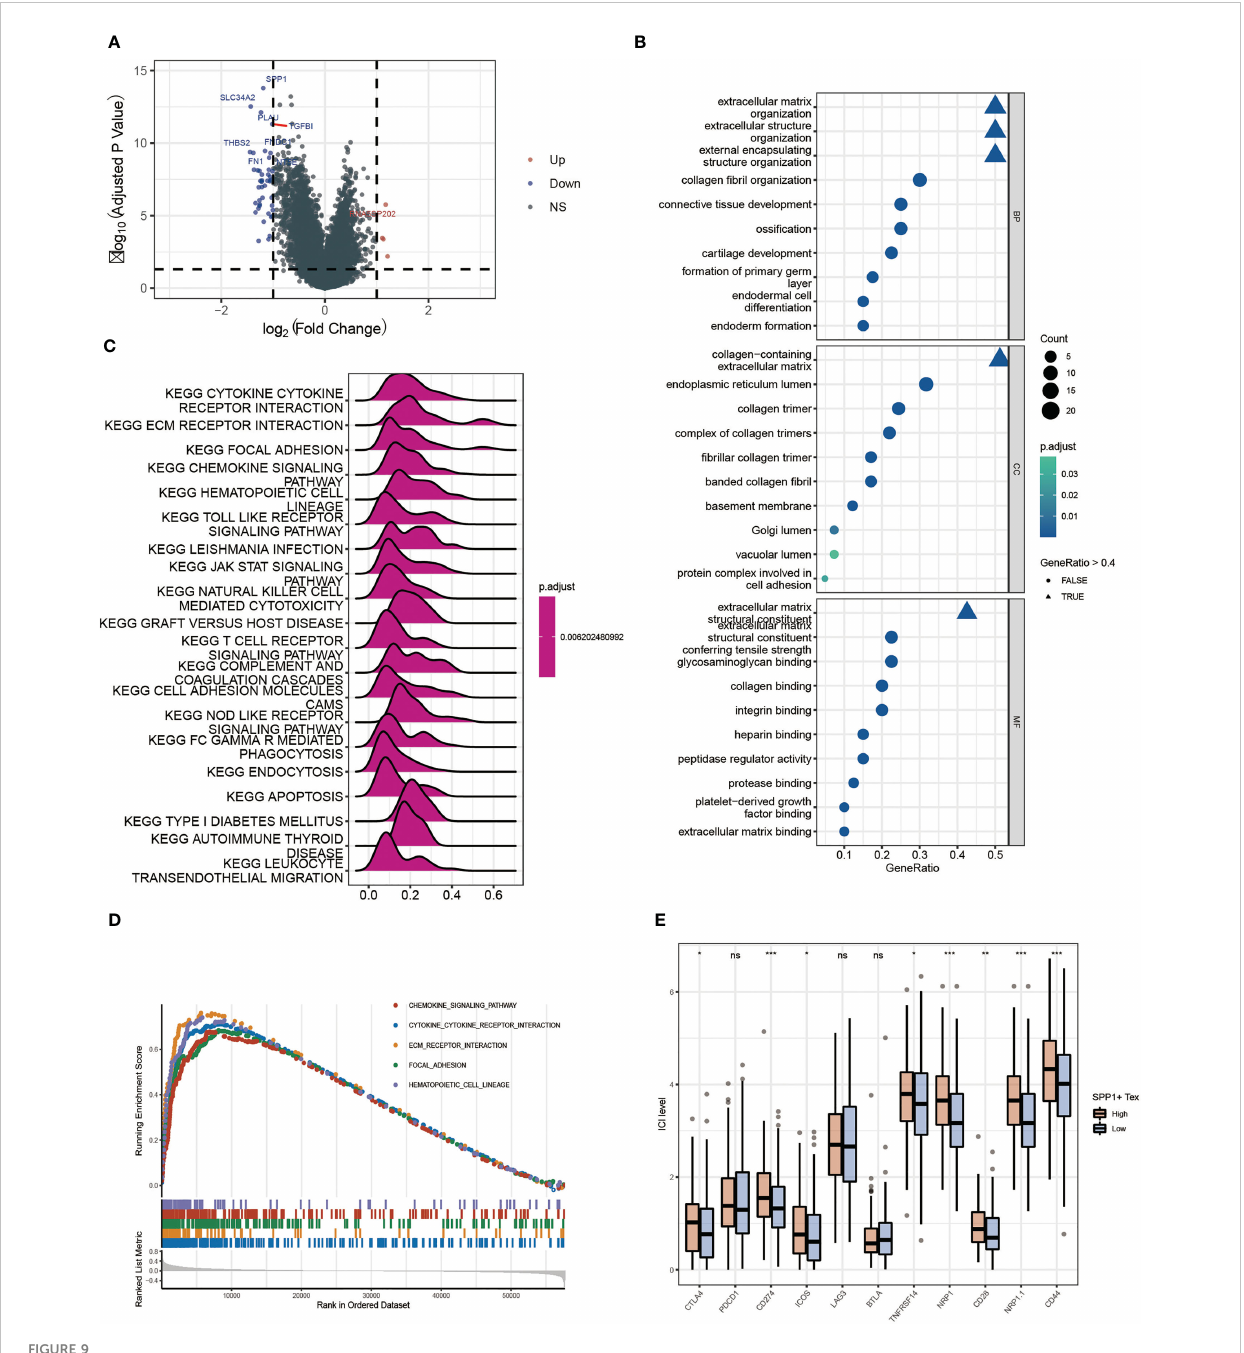
FIGURE 9 Differential enrichment analysis between high and low SPP1 + Tex groups. (A) Volcano plot of differentially expressed genes analysis between high and low groups. (B) GO enrichment analysis bubble plot. (C) Ridge plots for KEGG enrichment analysis. (D) Pathway plots for GSEA enrichment analysis. (E) Box plots show results of immune checkpoint analysis between SPP1 + Tex high and low groups. * means <0.05,** means <0.01, *** means <0.001. ns means